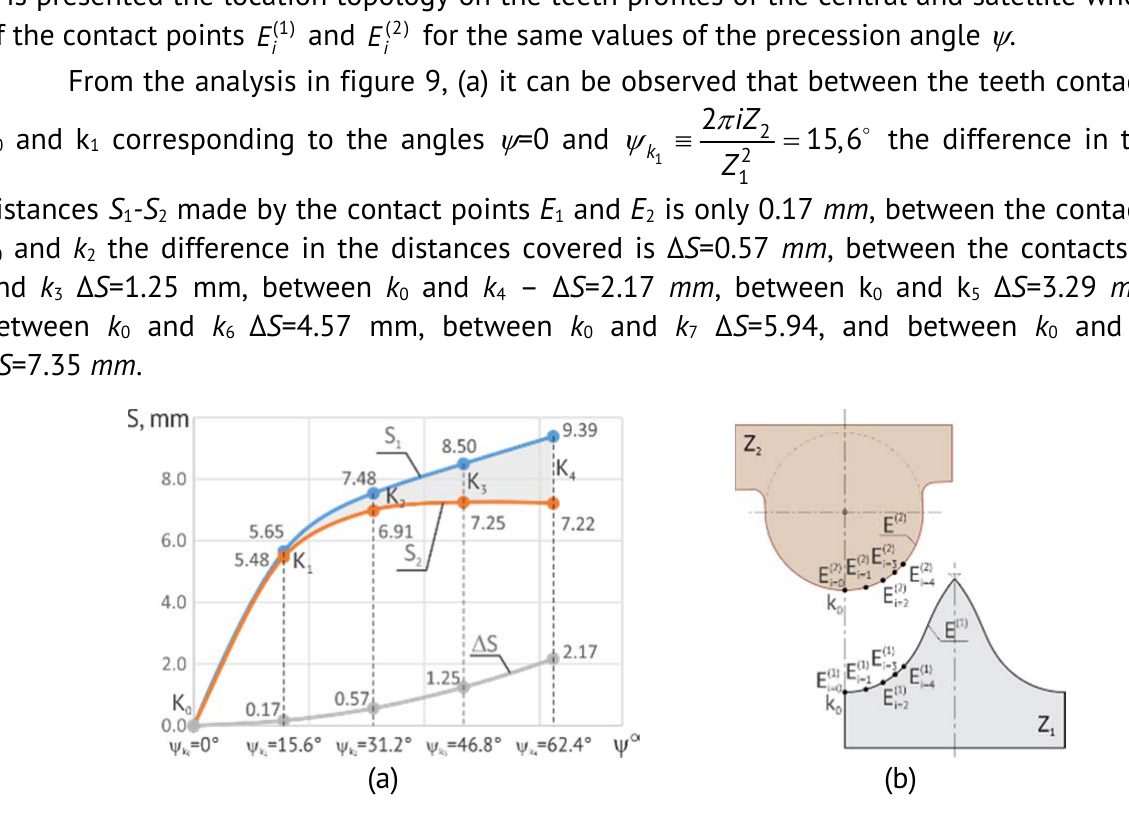
Figure 9. Distances S and S traveled by the contact points E 1 2 with  and  and their difference  S for the gear with the modified shape of the teeth 0 k 8 k (a) and the location topology on the profiles of the similar contact points and (precessional gear Z =24, Z =25,  = 3.5º,  = 22.5º,  = 4.78º, r= 6.27, R= 75 mm 1 2